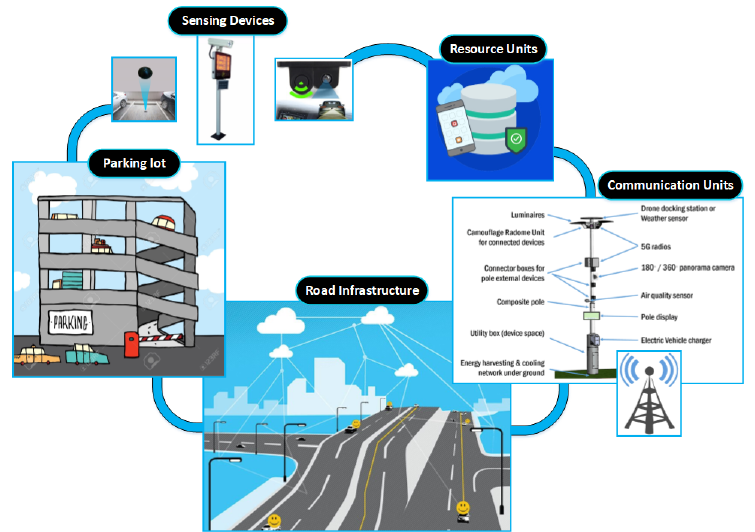
Figure 1. Basic components of the routing and parking